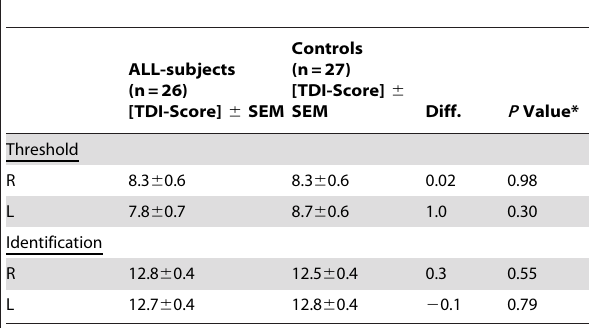
Table 5. Results from olfactory function